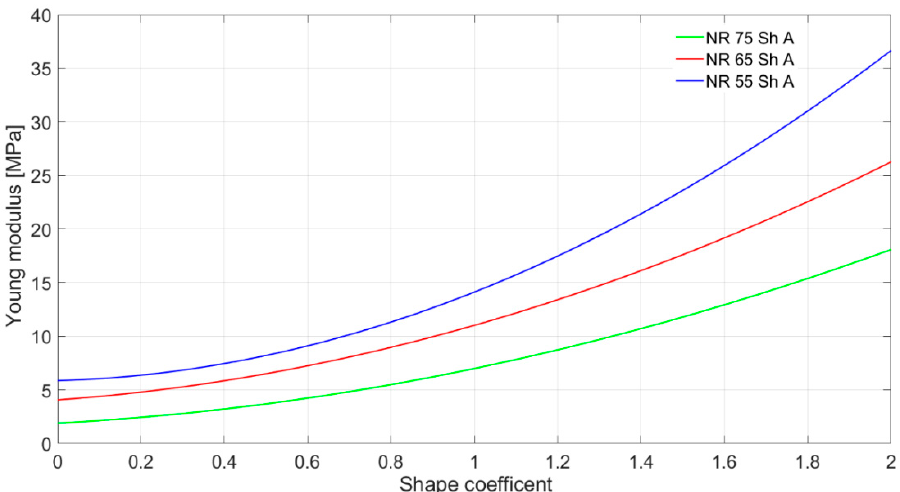
Figure 6. The results of the static measurements of shock absorbers stiffness made of three natural rubber (NR) rubber types.